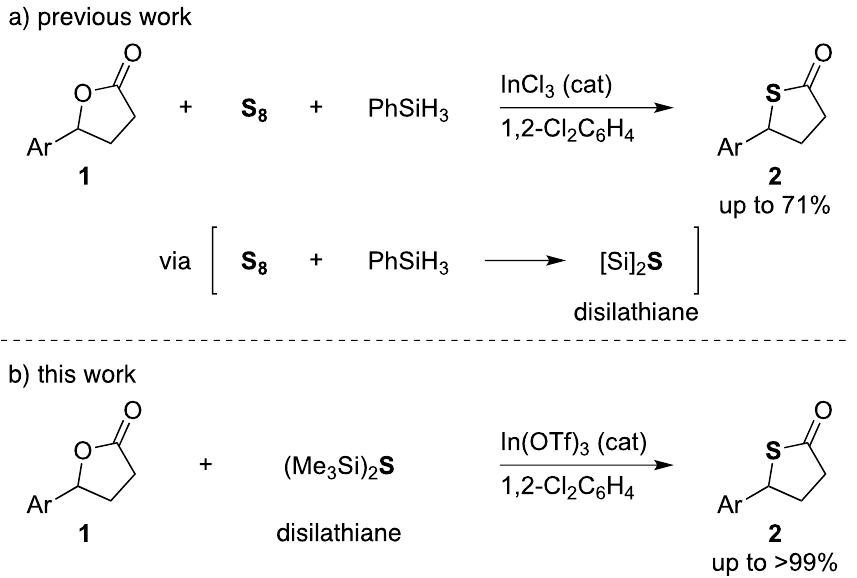
Table 1. Screening of the reaction conditions for the catalytic conversion of 1a to 2a a